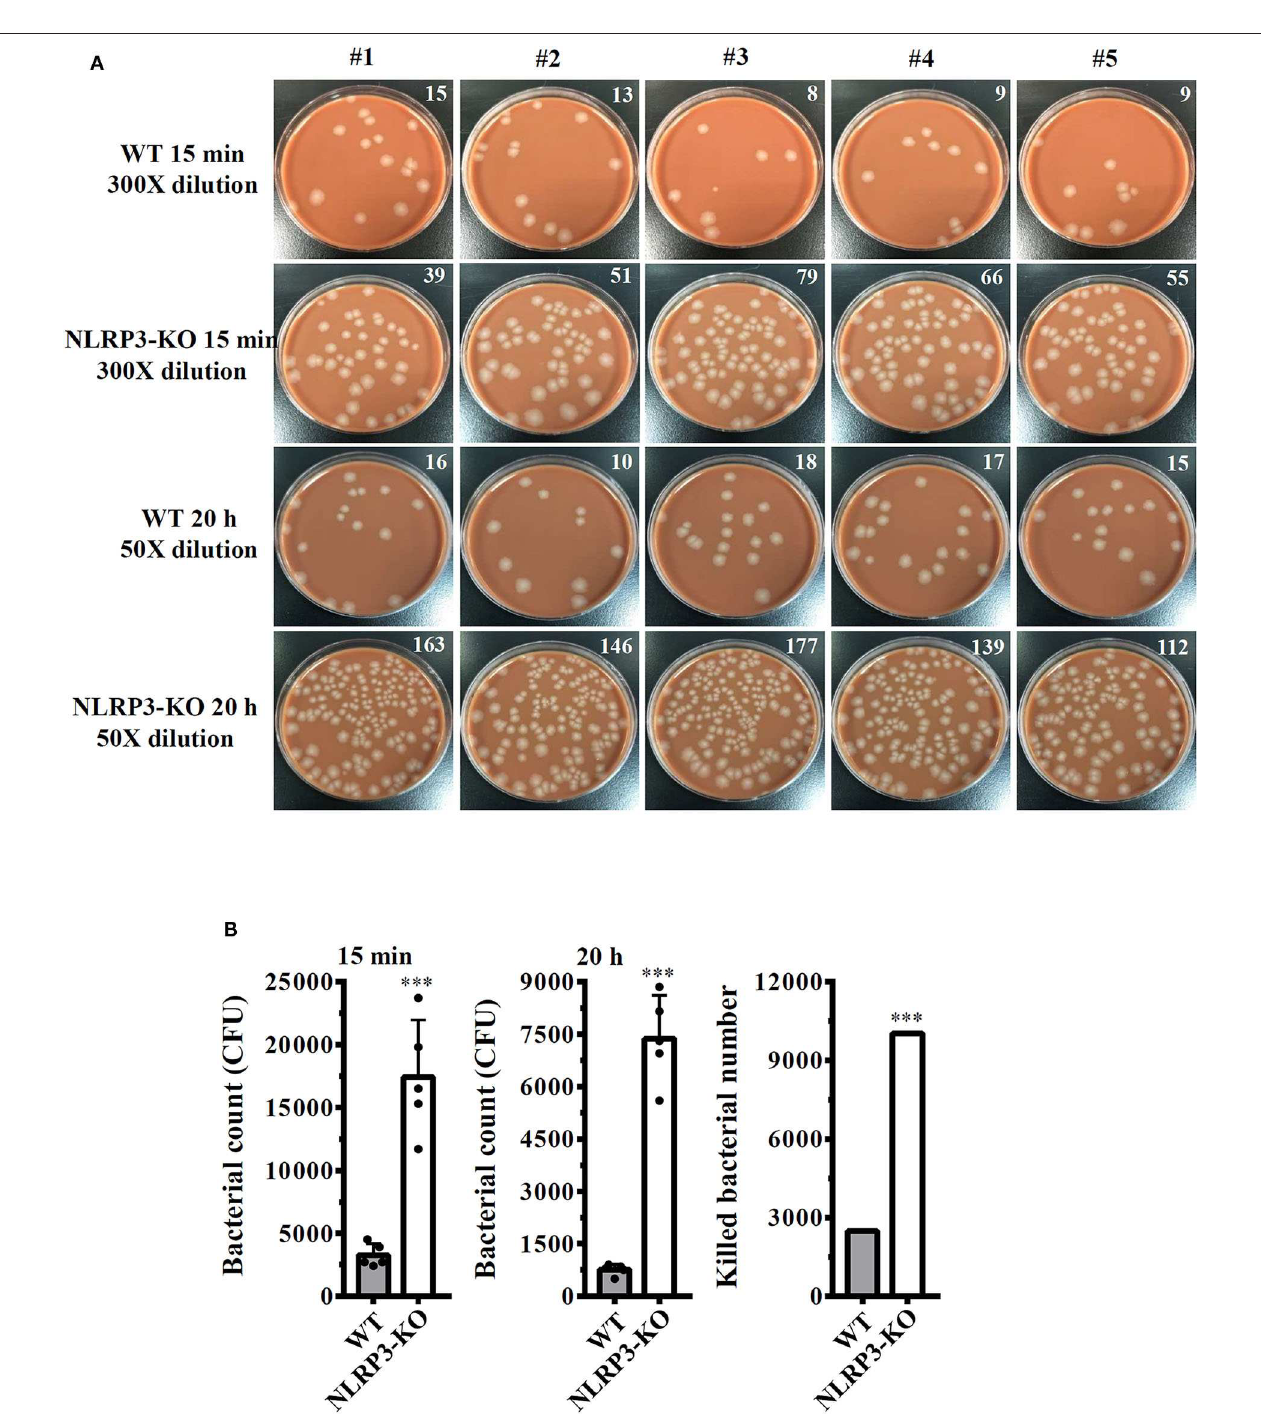
FIGURE 7 | NLRP3 knockout increases the bactericidal activity of macrophages against S. sonnei . (A,B) Wild-type or NLRP3-knockout J774A.1 macrophages were infected with 50 MOI S. sonnei for 15min or 20h. The cells were lysed, and the number of engulfed live S. sonnei cells was determined by the CFU assay and is indicated in the upper right corner (A) . The mean CFUs of cells infected with S. sonnei for 15min or 20h and the number of killed bacteria were calculated by subtracting the 20h CFU assay result from the 15min CFU assay result and are shown in panel (B) . The data are expressed as the mean ± SD of five separate experiments. ***indicates a significant difference at the level of p < 0.001 compared to wild-type cells (two-tailed t- test).